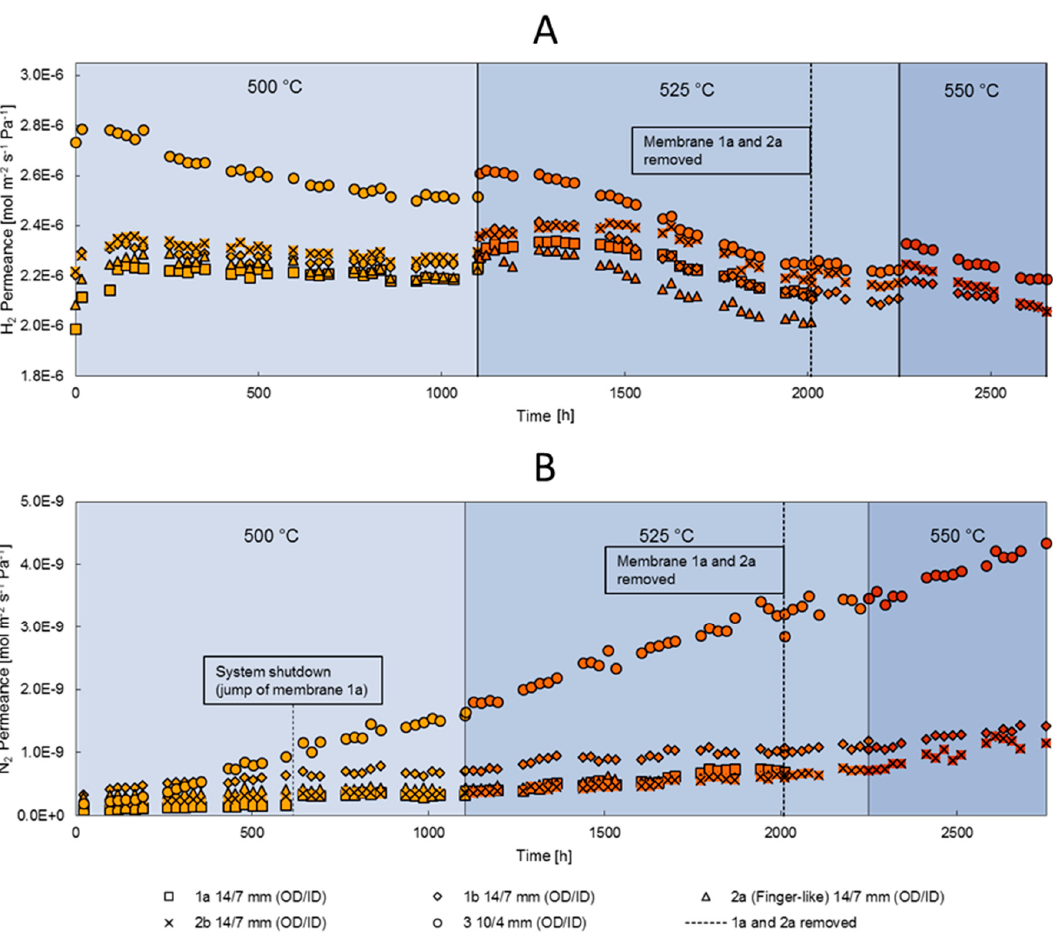
Figure 5. Long-term hydrogen permeance ( A ) and nitrogen permeance ( B ) of membranes 1a, 1b, 2a, 2b and 3 at 500 °C, 525 °C and 550 °C.